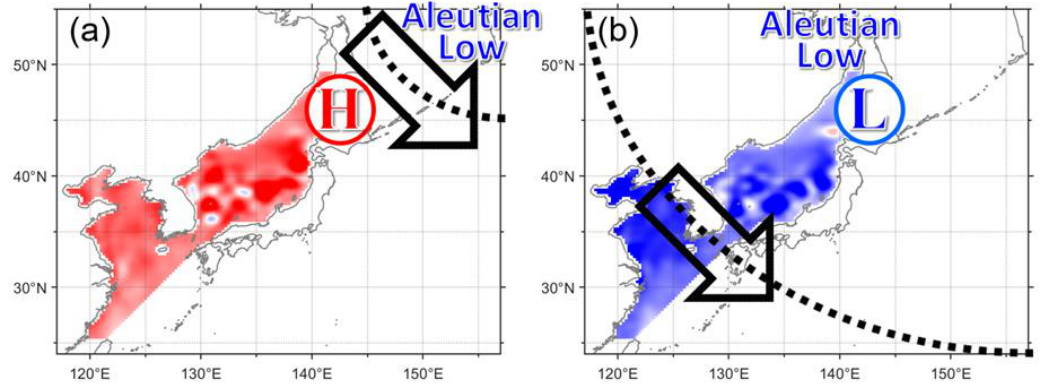
Figure 10. Schematic diagrams accounting for the winter NEAMS sea level anomalies. ( a ) A stronger winter monsoon with northwesterly wind or southeastward wind stress (black arrows) and associated atmospheric pressure gradients (black dotted lines) in the southern SO; e.g., the northeastward retreat of the Aleutian Low obstructs the outflow transport from the ES into the Pacific by Ekman dynamics to yield a higher (red) NEAMS sea level during Period H. ( b ) In contrast, a stronger winter monsoon in the southern ES obstructs the inflow transport from the Pacific to the ECS shelf and to the ES to yield a lower (blue) NEAMS sea level during Period L.